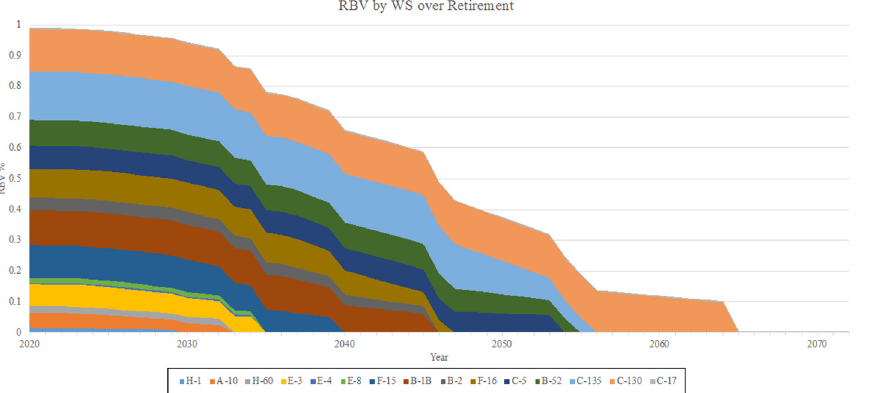
Figure 7. Unique parts by WS overretirement